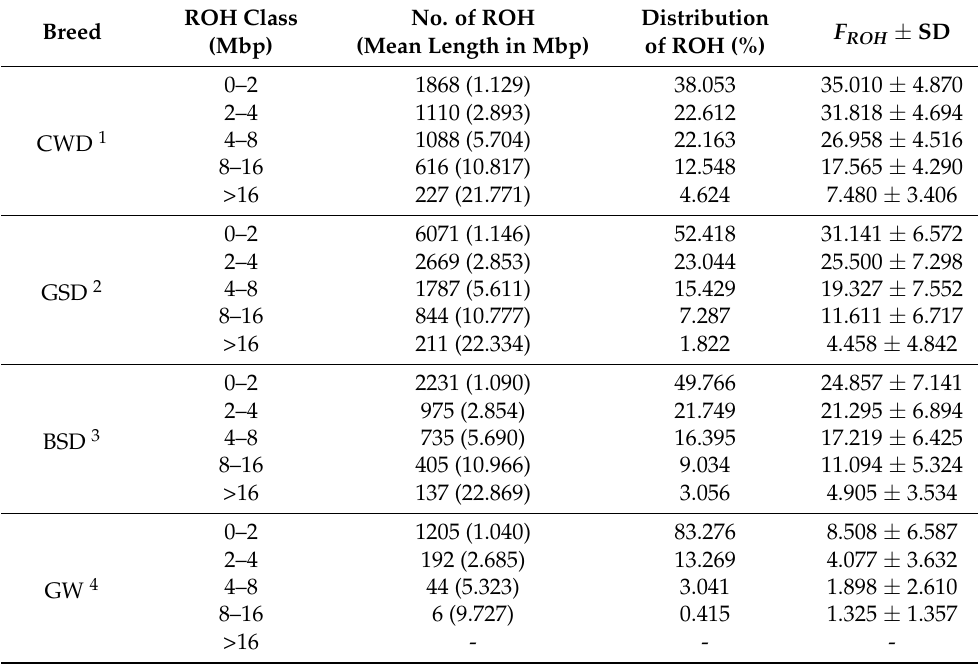
Table 2. Summary statistics for detected ROH per breed and ROH